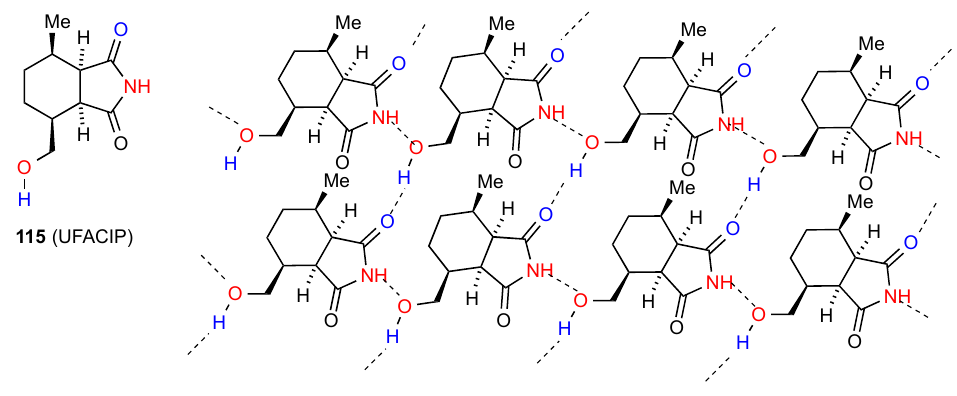
Figure 40. Structure adopted by compound 115.